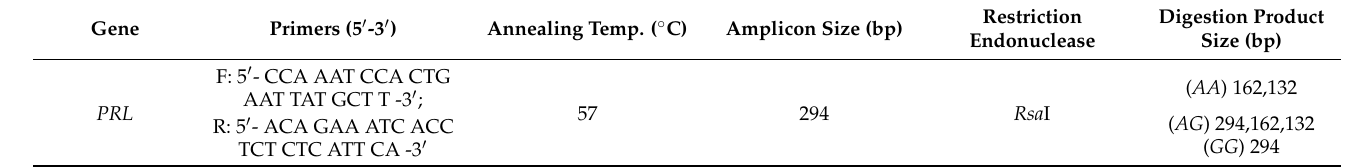
Table 1. The forward and reverse primers used for the amplification of PRL , PCR amplicon product size, restriction endonuclease, and genotypes according to the obtained digestion